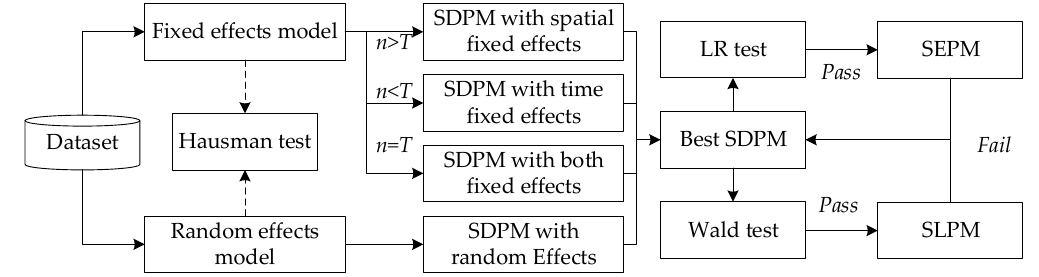
Figure 2. Model selection procedures of the spatial panel econometric models [37].